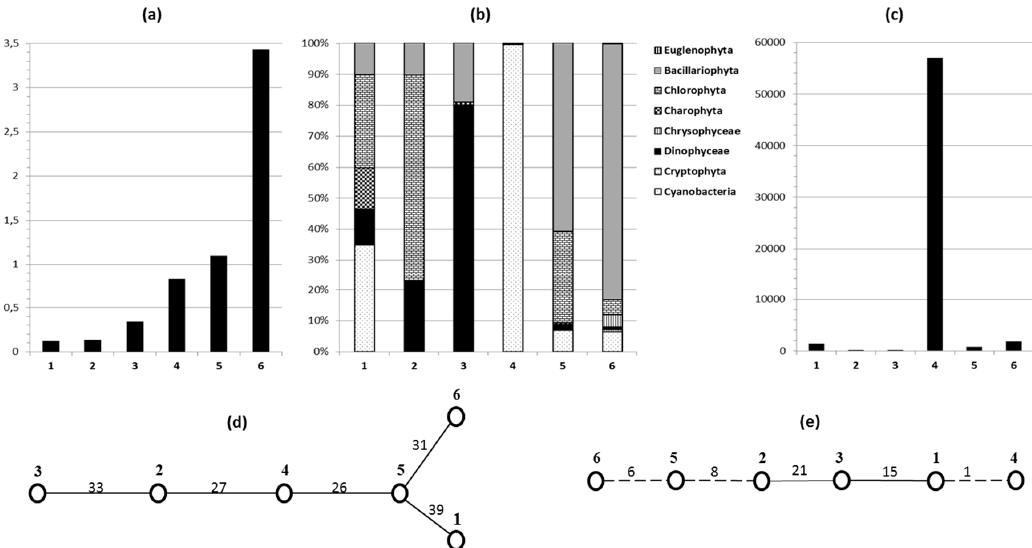
Figure 2. Phytoplankton communities under non-ferrous metallurgy impact. ( a ) Biomass, g/m 3 ; ( b ) abundance proportion of the large taxa categories, by percent ( c ) abundance, ind./l; dendrogram of the algae communities’ similarity using the Sörensen–Czekanowski coefficient: ( d ) based on taxa presence; ( e ) based on taxa abundance (1: Kumuzhie, 2: Sopchjavr, 3: Pyslyschimjavr, 4: Travyanoe, 5: Nyudjavr, 6: Monche Bay of Lake Imandra).